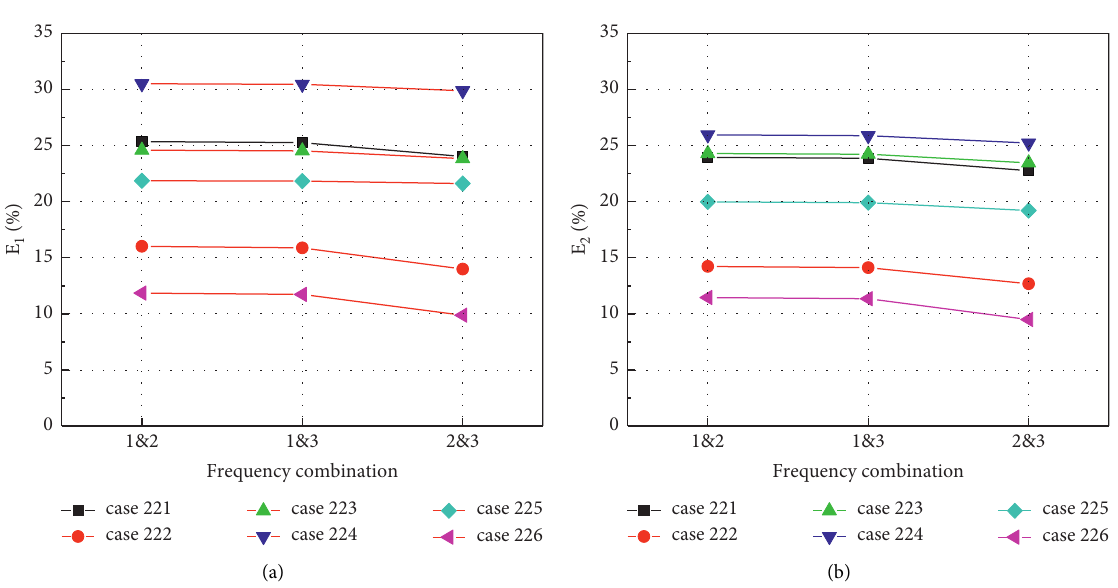
Figure 11: Calculation errors of isolation layer displacement by using NP-RD (PGA � 0.2g): (a) E1 and (b)